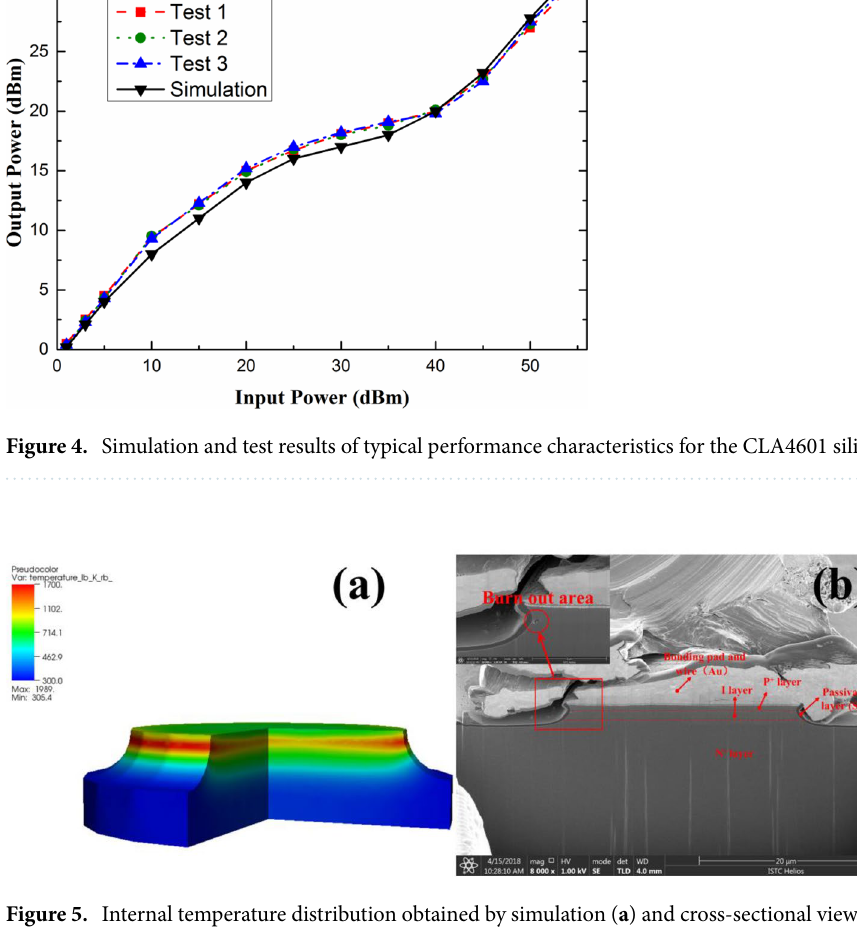
Figure 5. Internal temperature distribution obtained by simulation ( a ) and cross-sectional view via dual beam FIB cross section analysis ( b ) of the burnt-out CLA4601 silicon limiter.